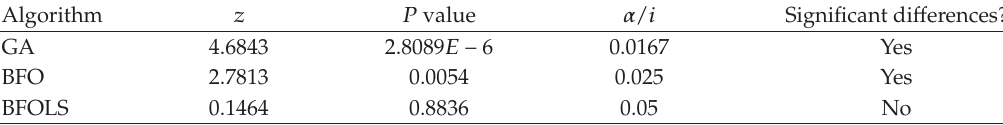
Table 6: Results of Holm’s test with dimension of